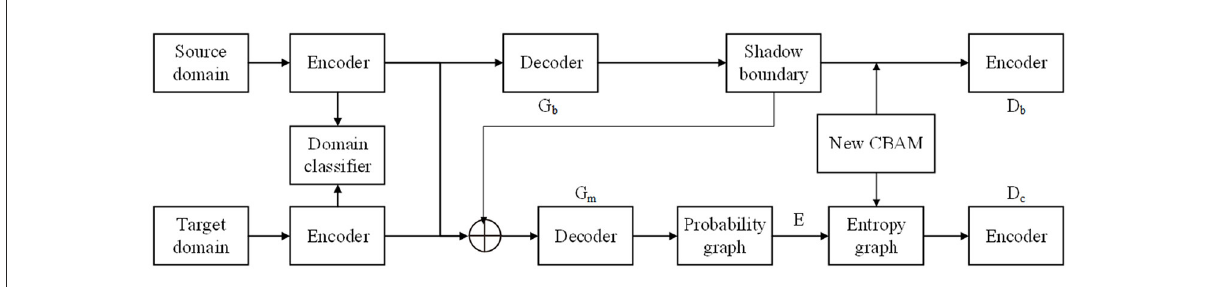
FIGURE2 Proposed single robot image shadow detection.